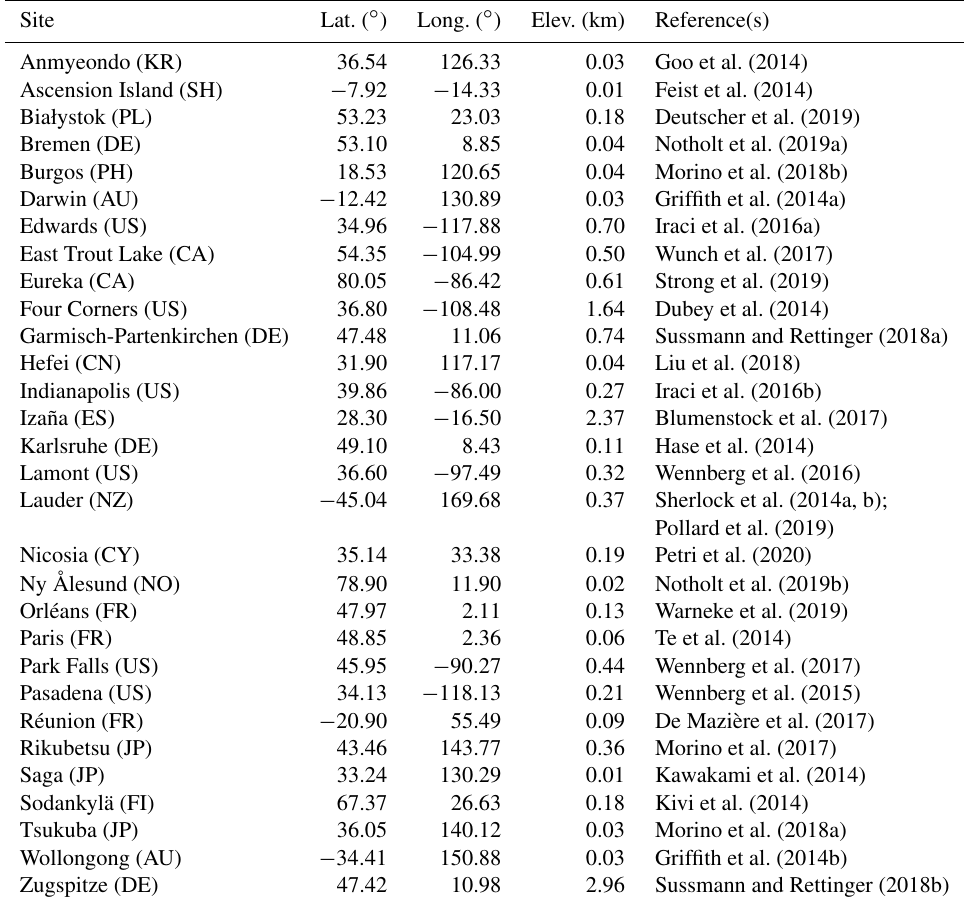
Table 1. TCCON stations used in this study (update of similar table in Noël et al.,